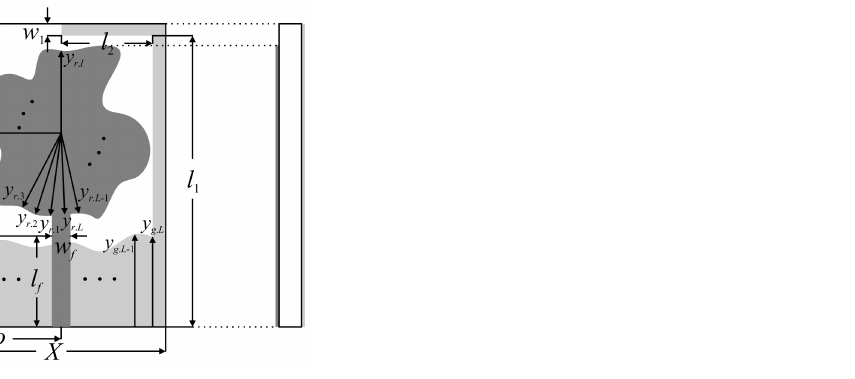
Figure 1. Geometry of the proposed spline-parameterized monopole antenna with highlights on its design parameters, showing top and cross-section views. The dark and light gray areas represent the radiator and ground-plane layers,